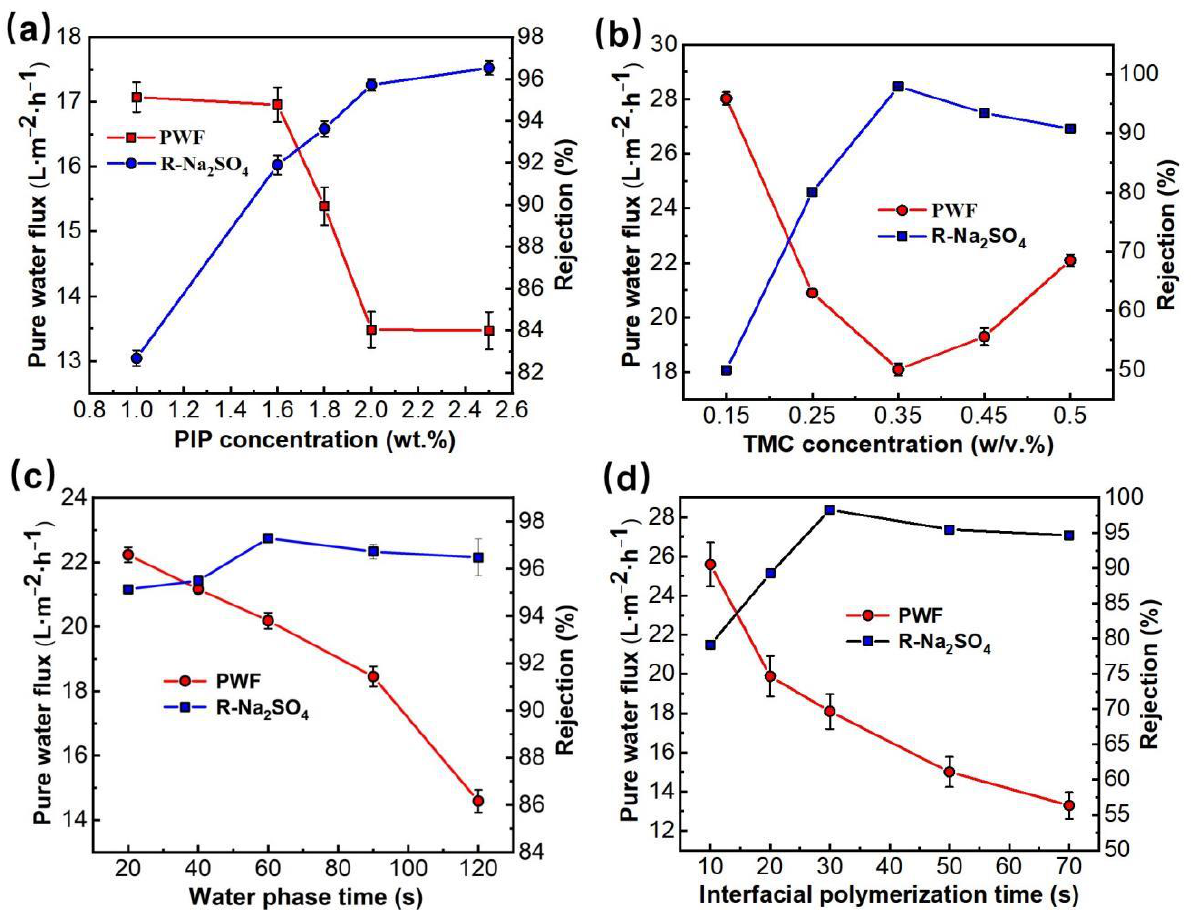
Figure 2. The effects of preparation conditions on the separation properties of the PMIA HF TFC NF membrane. ( a ) the effect of PIP concentration (TMC concentration was 0.35 w / v %, and the water phase soak and IP reaction time were 1 min and 20 s, respectively). ( b ) the effect of TMC concentration (PIP concentration was 1.8 wt.%, and the water phase soak and IP reaction time were 1 min and 20 s, respectively). ( c ) the effect of water phase soak time (PIP and TMC concentrations were 1.8 wt.% and 0.35 w / v %, respectively, and the IP reaction time was 20 s). ( d ) the effect of IP reaction time (PIP and TMC concentrations were 1.8 wt.% and 0.35 w / v %, respectively, and water phase soak time was 1 min).